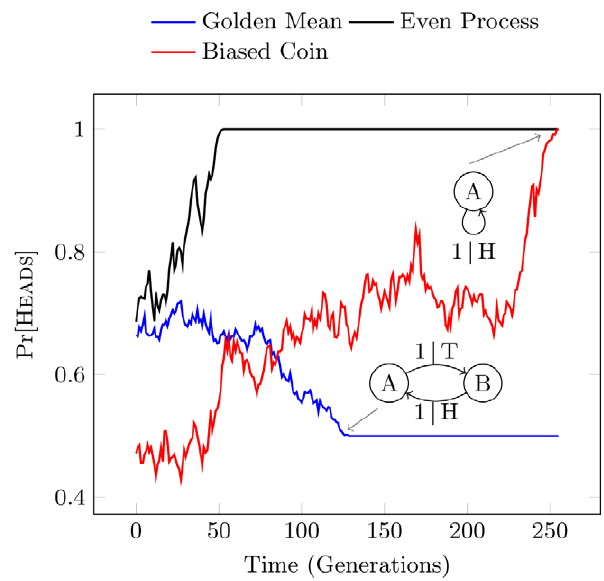
Figure 8. Drift of Pr[H EADS ] for a single realization of the Biased Coin, Golden Mean, and Even Processes, plotted as a function of generation. The Even and Biased Coin Processes become the Fixed Coin Process at stasis, while the Golden Mean Process becomes the Alternating Process. Note that the definition of structural stasis recognizes the lack of variance in the Alternating Process subspace even though the allele probability is neither 0 nor 1.